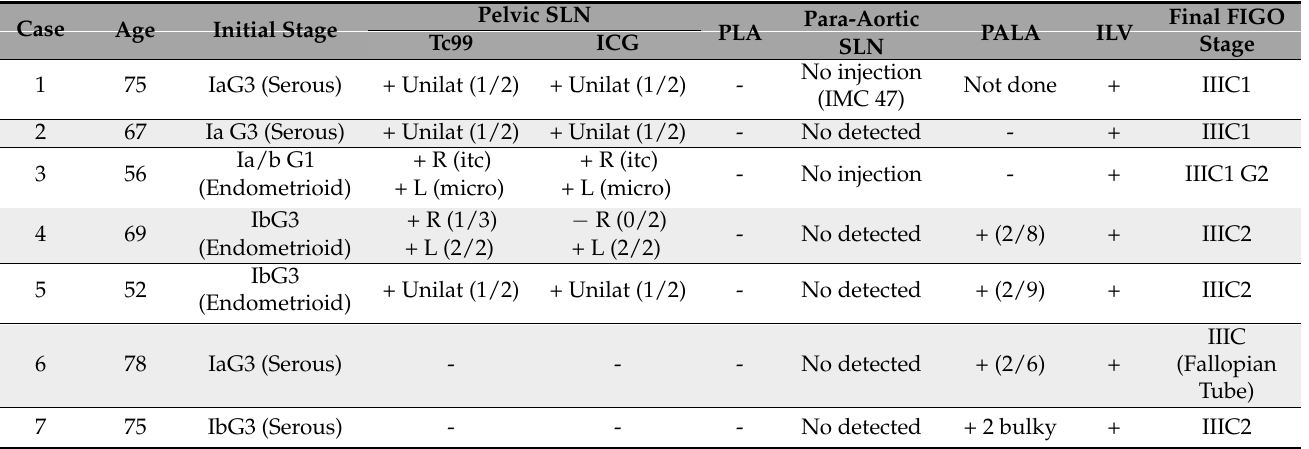
Table 5. Lymph node metastases (7/48 patients): PLA, pelvic lymphadenectomy; PALA, para-aortic lymphadenectomy; +, positive histopathology; -, negative histopathology.